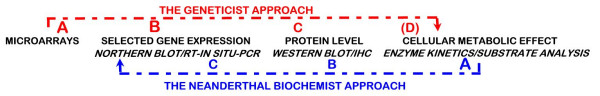
A comparison of the "geneticist approach" versus the "biochemist approach" in the marriage of molecular genetics/proteomics with cellular intermediary metabolism.